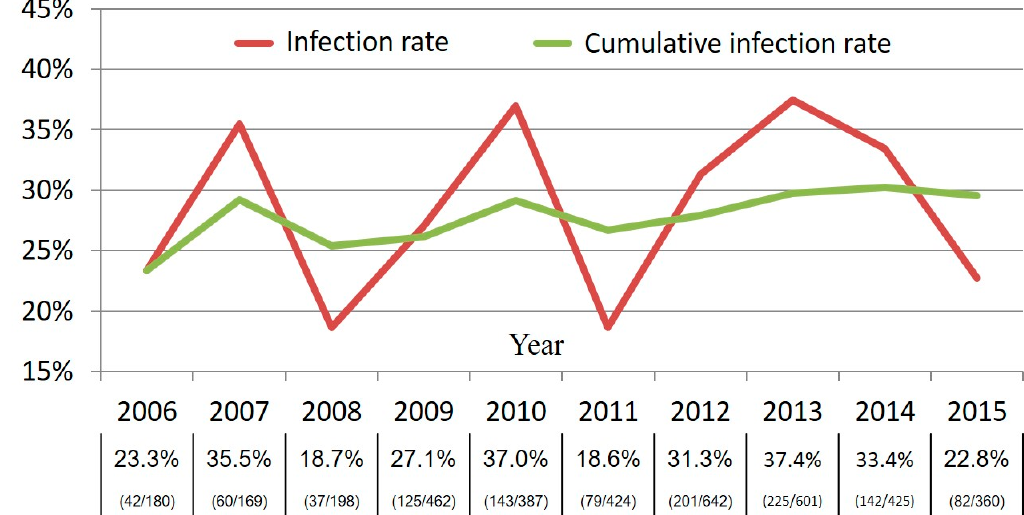
Figure 4. The infection rate and cumulative infection rate of tilapia streptococcosis in Taiwan during 2006–2015. It is observed that high infection rate peaks every three years and the cumulative infection rate of tilapia streptococcosis shows the trend of increasing from 23.3% (2006) to 29.5% (2015).